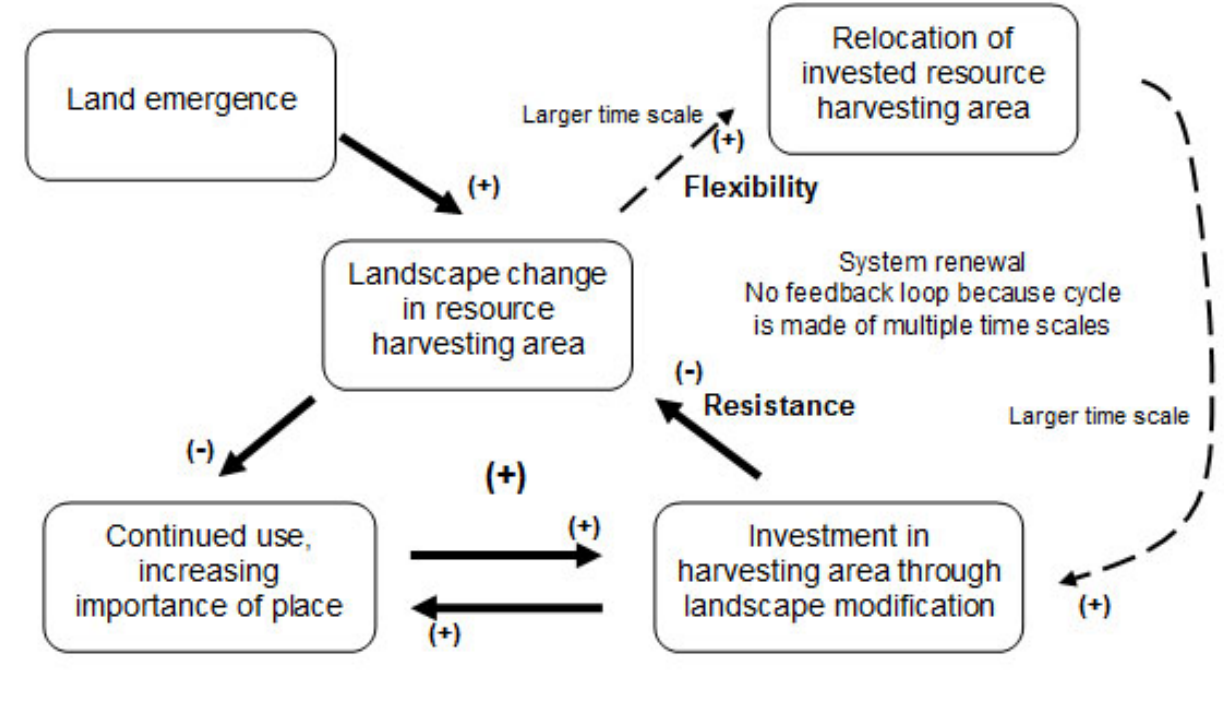
Fig. 7 . Feedback diagram depicting resistance and flexibility in context of landscape modification for resource harvesting. Plus signs indicate a positive relationship, or a direct relationship of increase or decrease between one parameter and the parameters it influences. Negative signs indicate a negative relationship, or an opposite relationship of increase or decrease between one parameter and the parameters it influences. Solid arrows and dashed arrows represent two different temporal scales with the latter being larger. Dashed arrows and solid arrows do not create closed feedback loops because of their different